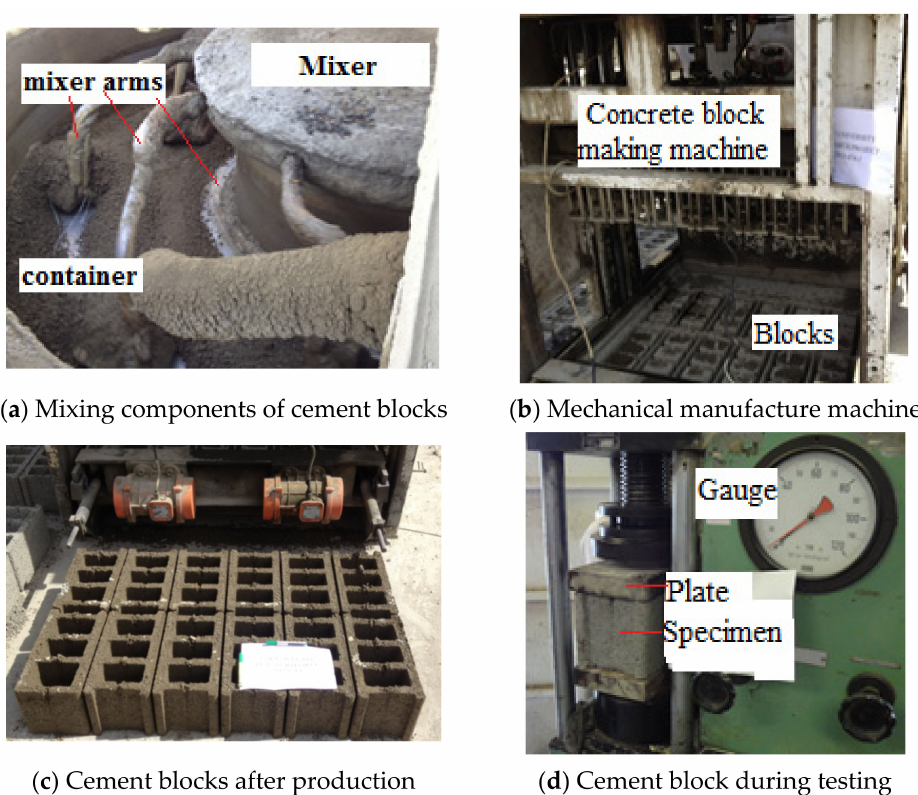
Figure 6. Hollow blocks, and stages of manufacture and under testing: ( a ) mixing components of cement blocks; ( b ) mechanical manufacture machine; ( c ) cement blocks after production; ( d ) cement block during